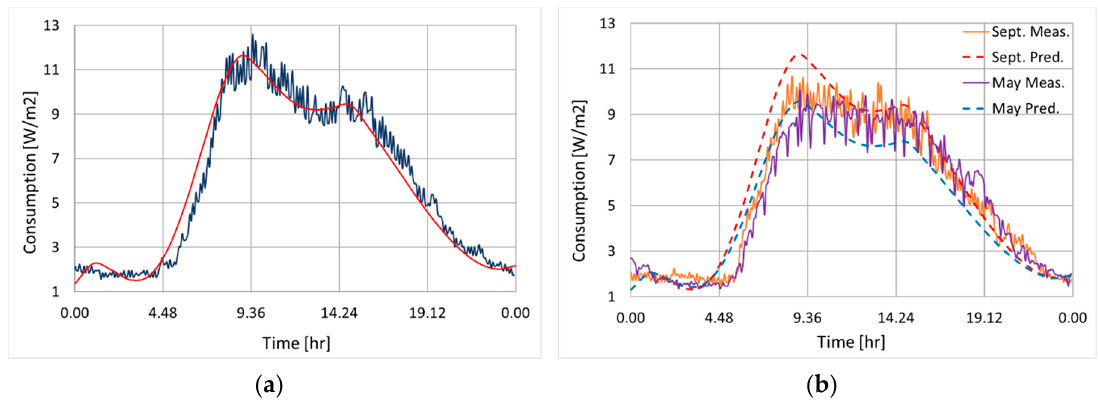
Figure 10. Interpolations vs. data: ( a ) 24th January 2018; ( b ) May and September, weekdays.